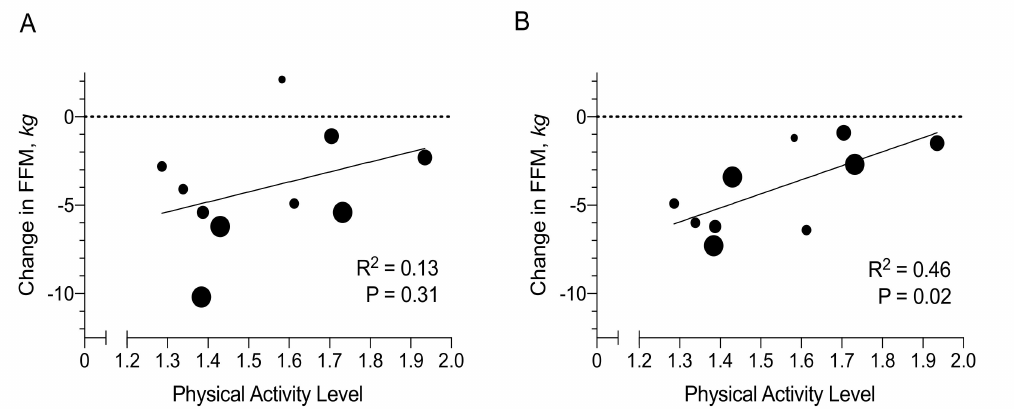
Figure 2. Physical Activity and Changes in Fat-free Mass. The association between the physical activity level and change in fat-free mass during a 3-month deployment onto military submarine is presented before ( A ) and after ( B ) adjustment for body mass index ( n = 10). Larger size of each data point indicates higher baseline BMI (range from 20.0 to 30.2 kg / m 2 ). The association between physical activity level and change in fat-free mass was assessed by linear